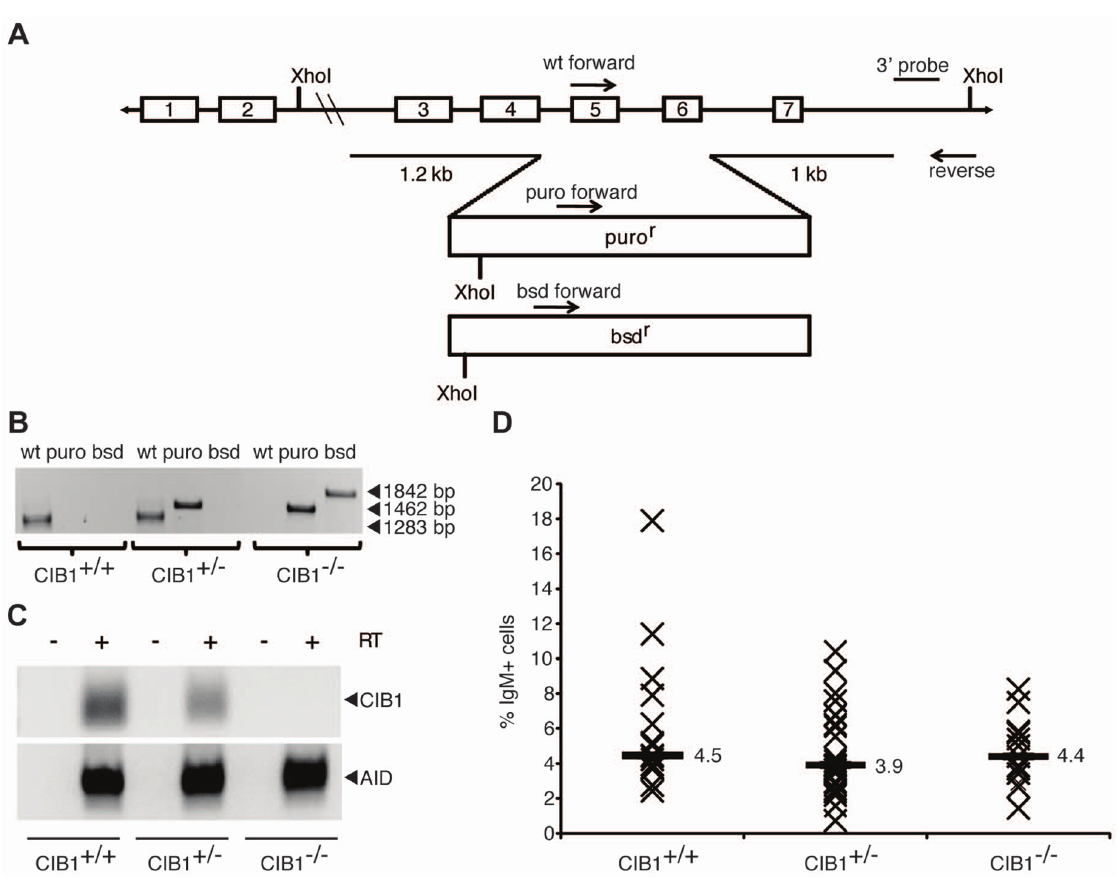
Figure 3. CIB1 is dispensable for immunoglobulin gene conversion in DT40. A . Schematic showing the constructs used to replace exons 5 and 6 of CIB1 with the indicated drug resistance cassettes. The positions of the allele-specific PCR primers for genotyping and the XhoI sites and the position of the 3 9 external probe used for Southern blot analysis are shown. B . An agarose gel image showing the allele-specific PCR products from CIB1 + / + , + / 2 , and 2 / 2 cell lines. C . An agarose gel image of CIB1-specific RT-PCR products from CIB1 + / + , + / 2 , and 2 / 2 cell lines. AID-specific reactions were used to demonstrate the integrity of each cDNA preparation. D . An IGC fluctuation analysis showing the percentage of surface Ig- positive cells in subclone cultures of the indicated genotype. Each X represents data from an individual subclone and the labeled horizontal bars report the medians for each data set.